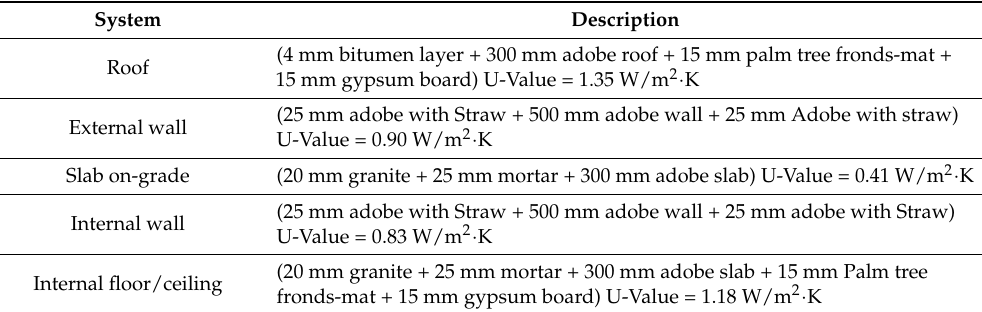
Table 5. Description and U-Values for the adobe construction systems.